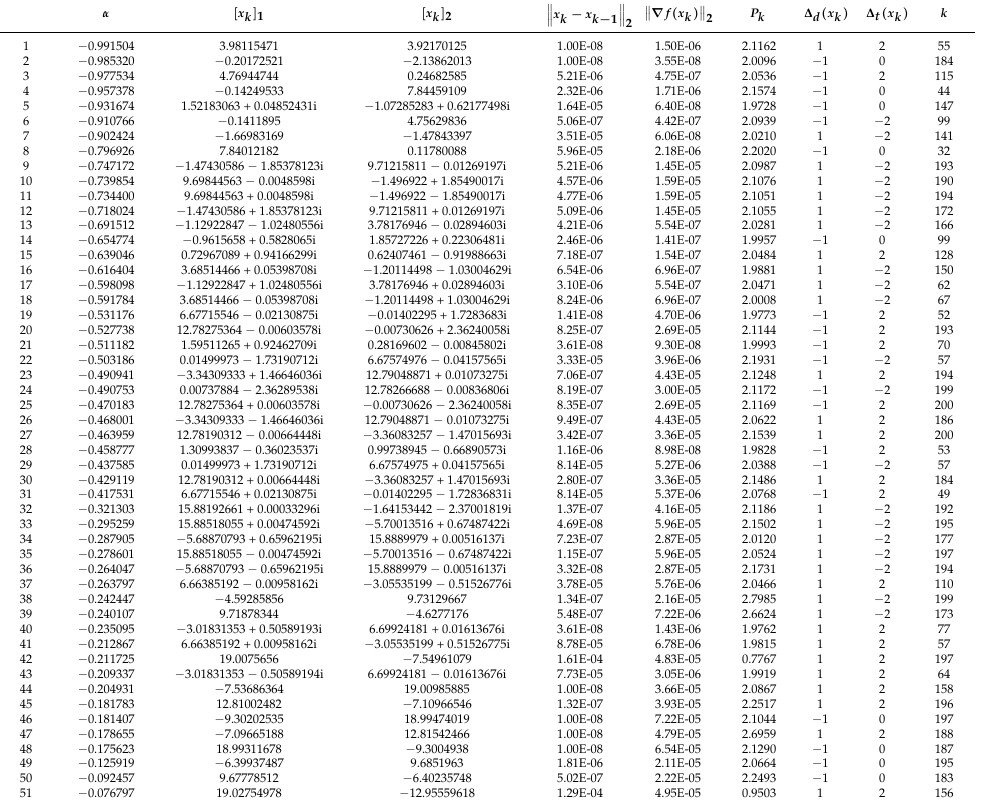
Table 2. Results obtained using the iteration function (74) with the fractional quasi-Newton method